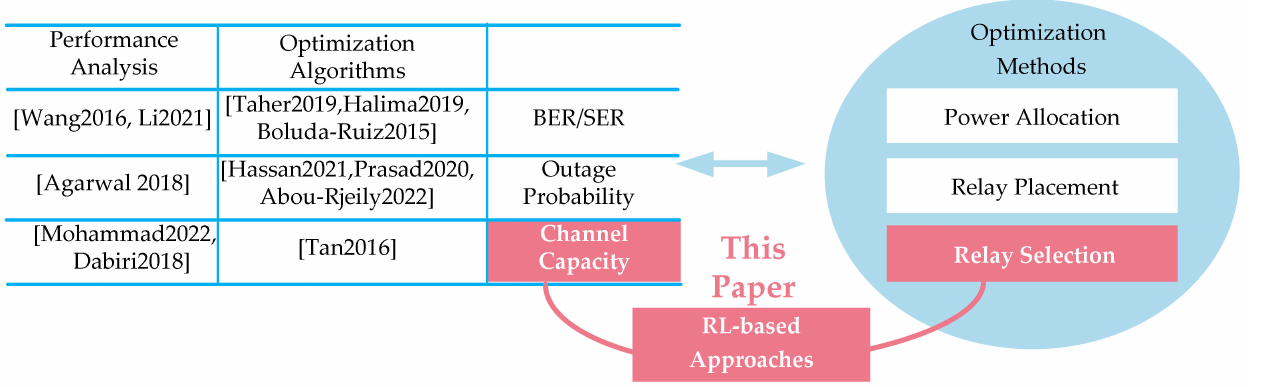
Figure 1. Literature review and the research content of this